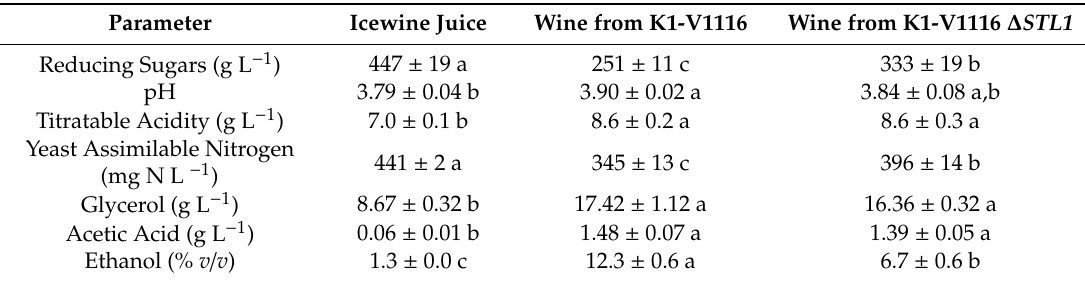
Table 1. Icewine juice and final wine chemical composition. Data represent the mean value ± standard deviation from triplicate fermentations, with each sample tested in duplicate. Lowercase letters within the same parameter indicate di ff erences between treatments as tested by ANOVA, with mean separation by Tukey’s Honest Significant Di ff erence (HSD 0.05